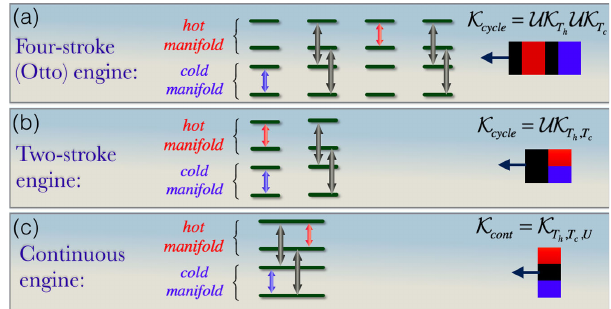
FIG. 3. Representation of the three types of engines (a) – (c) in the multilevel embedding framework. In this scheme, the differ- ent engine types differ only in the order of coupling to the baths and work repository. Since the interactions and energy levels are the same for all engine types, a meaningful comparison of performance becomes possible.